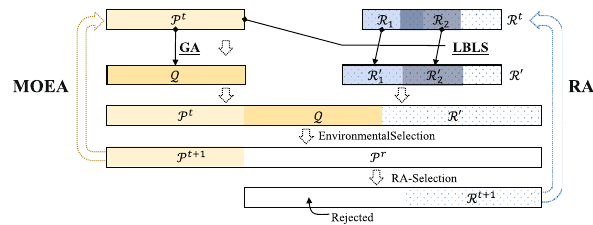
Fig. 3 The update diagram of the population and the robust archive in